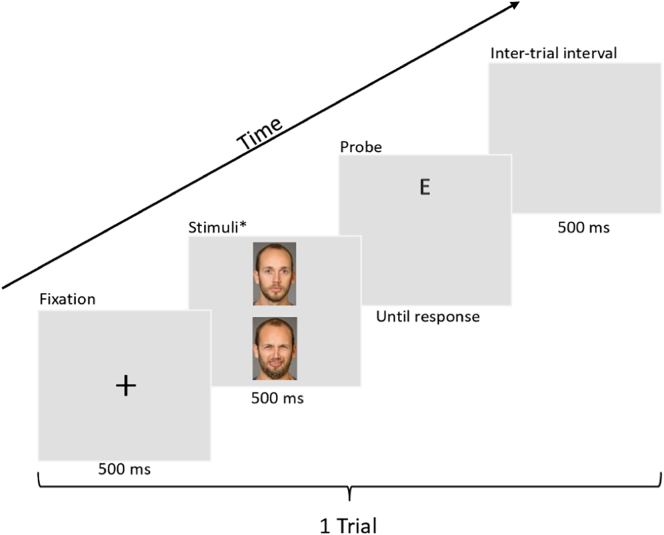
Example trial of a dot-probe task. Each trial began with a fixation cross appearing on screen for 500 ms. After the fixation cross, two faces from the same individual showing a neutral expression and a disgusted expression appeared on the screen (arranged vertically) for 500 ms. The position of the neutral/disgust expressions was counterbalanced, so that each expression appeared with equal frequency on top or bottom. After the faces disappeared, a probe (letter ‘E’ or letter ‘F’, with equal frequency) would appear randomly in the location previously occupied by a neutral expression or a disgusted expression with equal frequency. Participants were instructed to identify the probe as quickly as possible by pushing the controller joystick left (for ‘E’) or right (for ‘F’). A 500 ms inter-trial interval took place before a new trial began.*Note. The BP4D-Spontaneous database is proprietary, therefore the actual stimuli used are not permissible to print in publications. The faces shown in this example comes from the Umeå University Database of Facial expressions (Samuelsson et al., 2012). Examples of the VR environment (as seen on a computer monitor) can be found in Supplementary Materials.